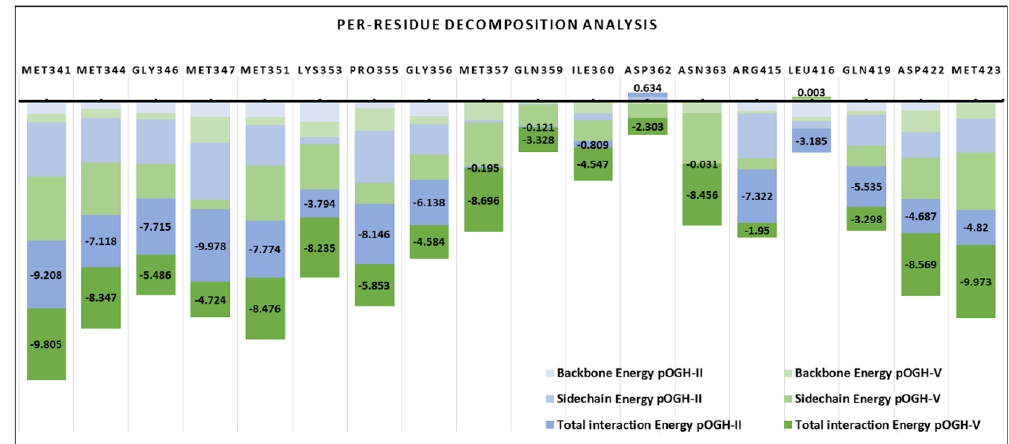
Figure 6. The stacking bar chart represented the binding free energy decomposition using the MM-GBSA method between the pOGH-2 and pOGH-5 complexed with the M-domain. Important residues for the M-domain binding groove are labeled on the top of each bar. The total interaction energies of key residues of binding groove with pOGH-2 (blue) and pOGH-5 (green) are displayed along with sidechain and backbone contributions with the same color gradient.